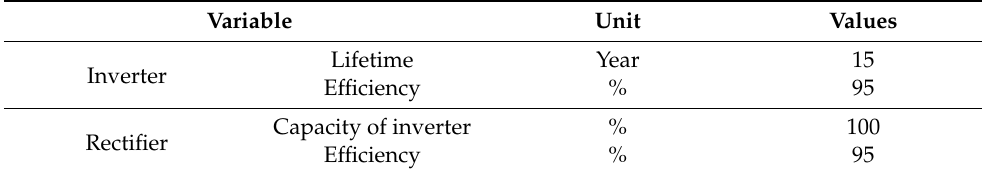
Table 5. Parameters of proposed inverter and rectifier.